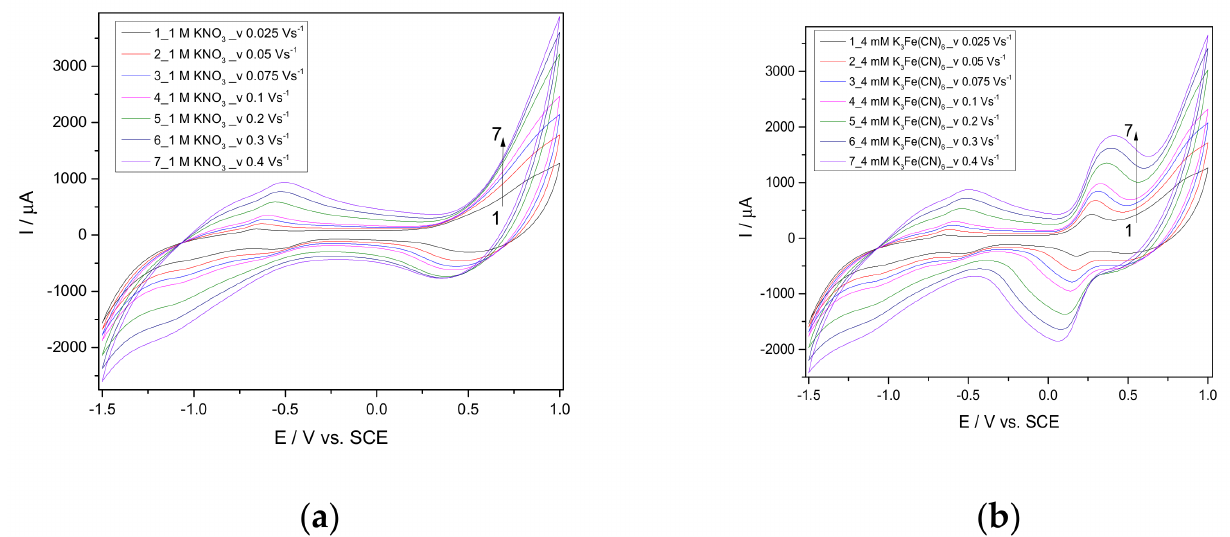
Figure 5. Cyclic voltammograms (CV) recorded at a CuBi/CNF modified electrode in a 1 M KNO 3 supporting electrolyte ( a ) and the presence of 4 mM K 3 [Fe(CN) 6 ] ( b ) at different scan rates: 0.025, 0.05, 0.075, 0.1, 0.2, 0.3, and 0.4 Vs − 1